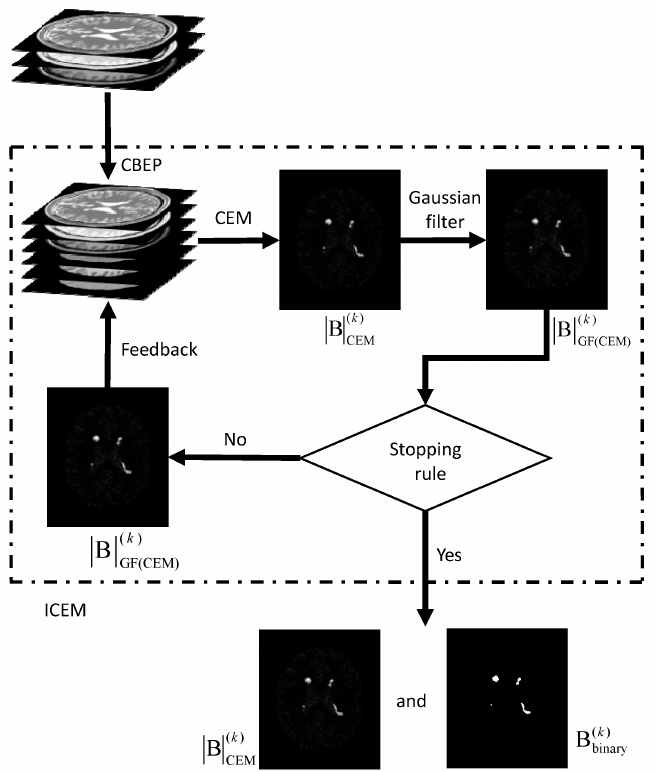
Figure 3. Graphic implementation of NBE-ICEM in Figure 1.